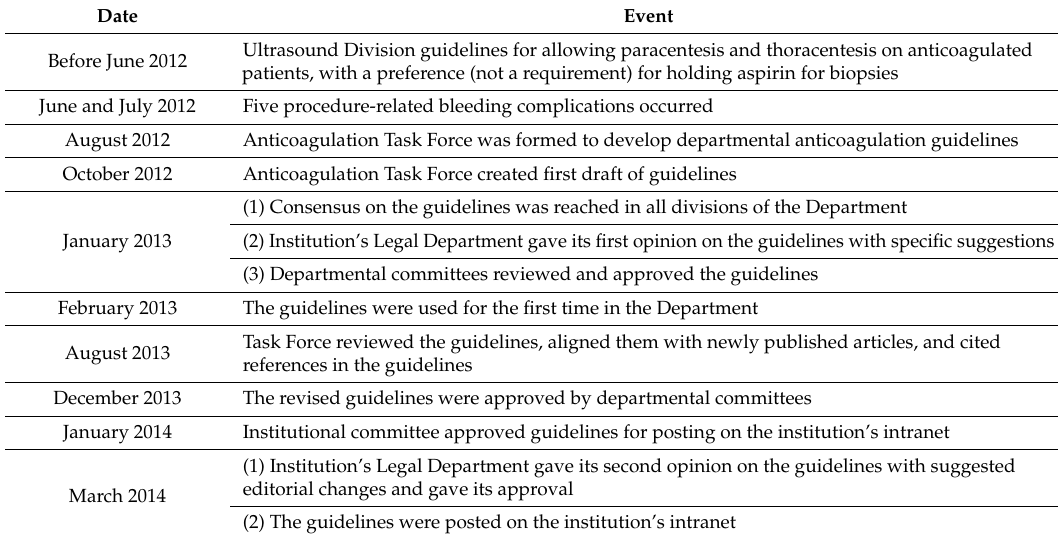
Table 1. Timeline of events in the Department of